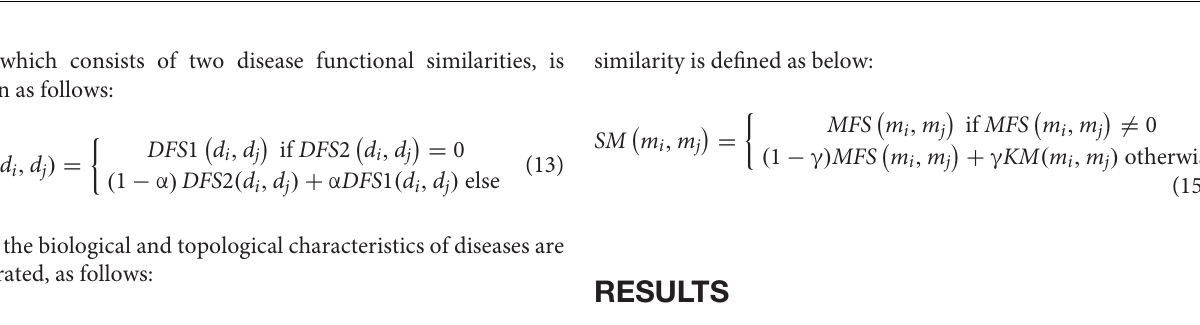
( DB ),which consists of two disease functional similarities,